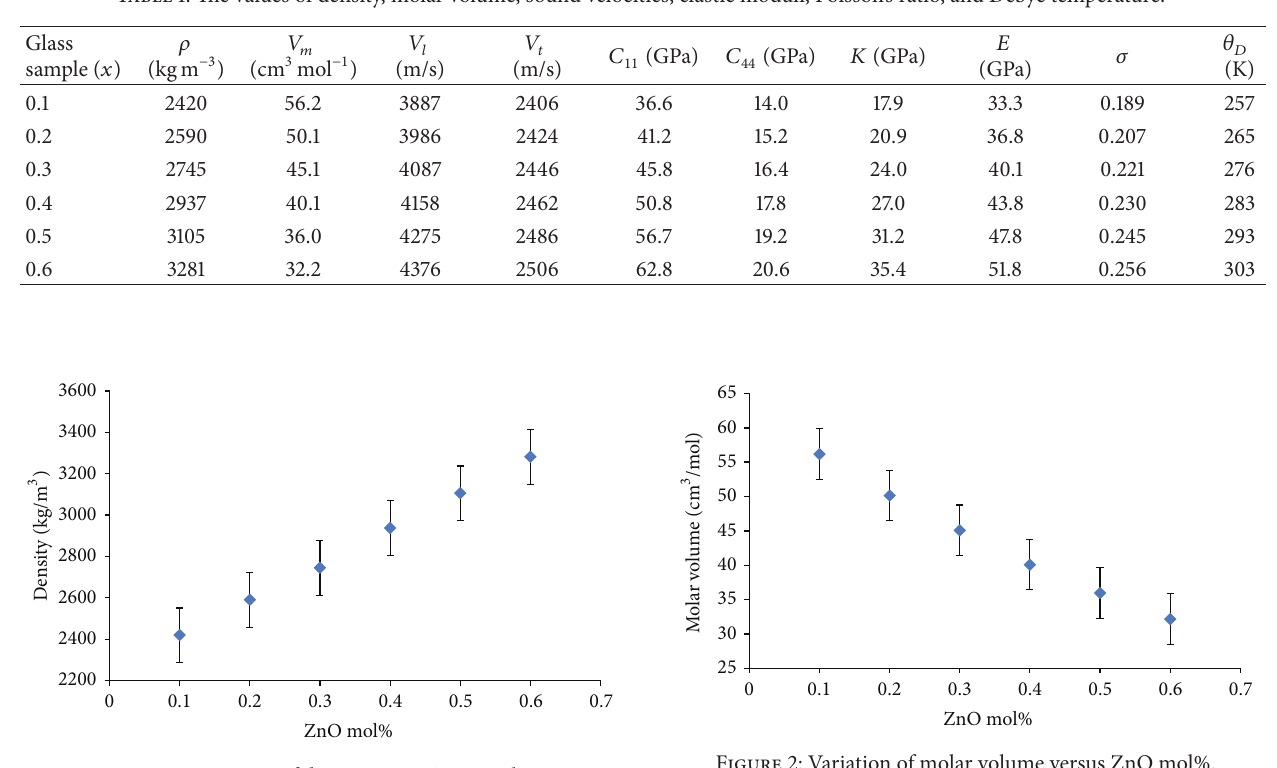
Figure 1: Variation of density versus ZnO mol%.